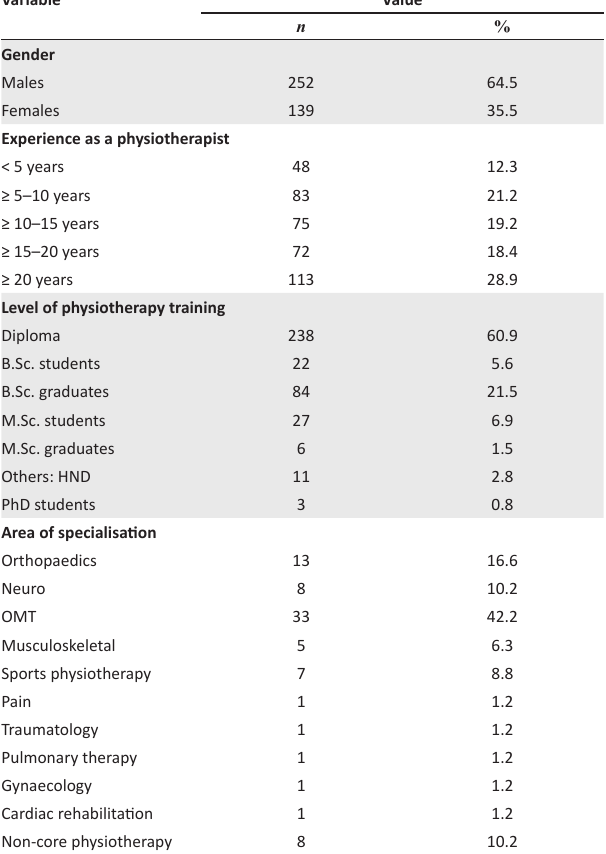
FIGURE 2: Sports discipline: Specific